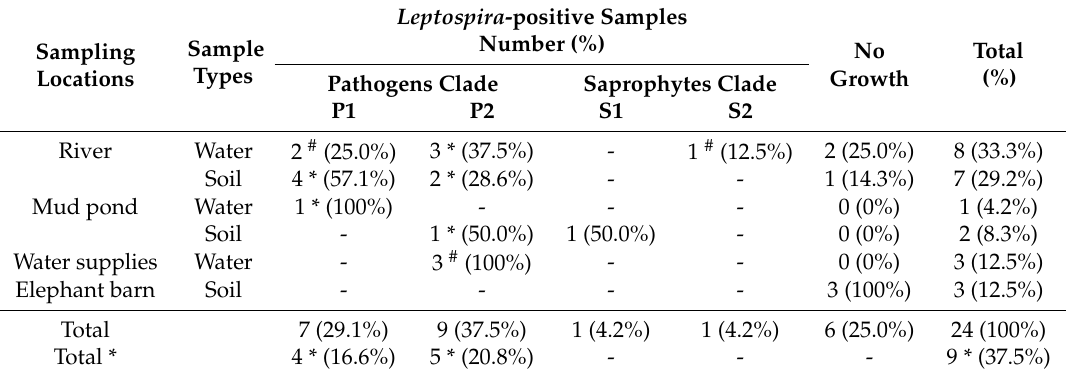
Table 1. Number and Percentage (%) of Leptospira spp. Recovered from the Environmental Samples in the Elephant Camp